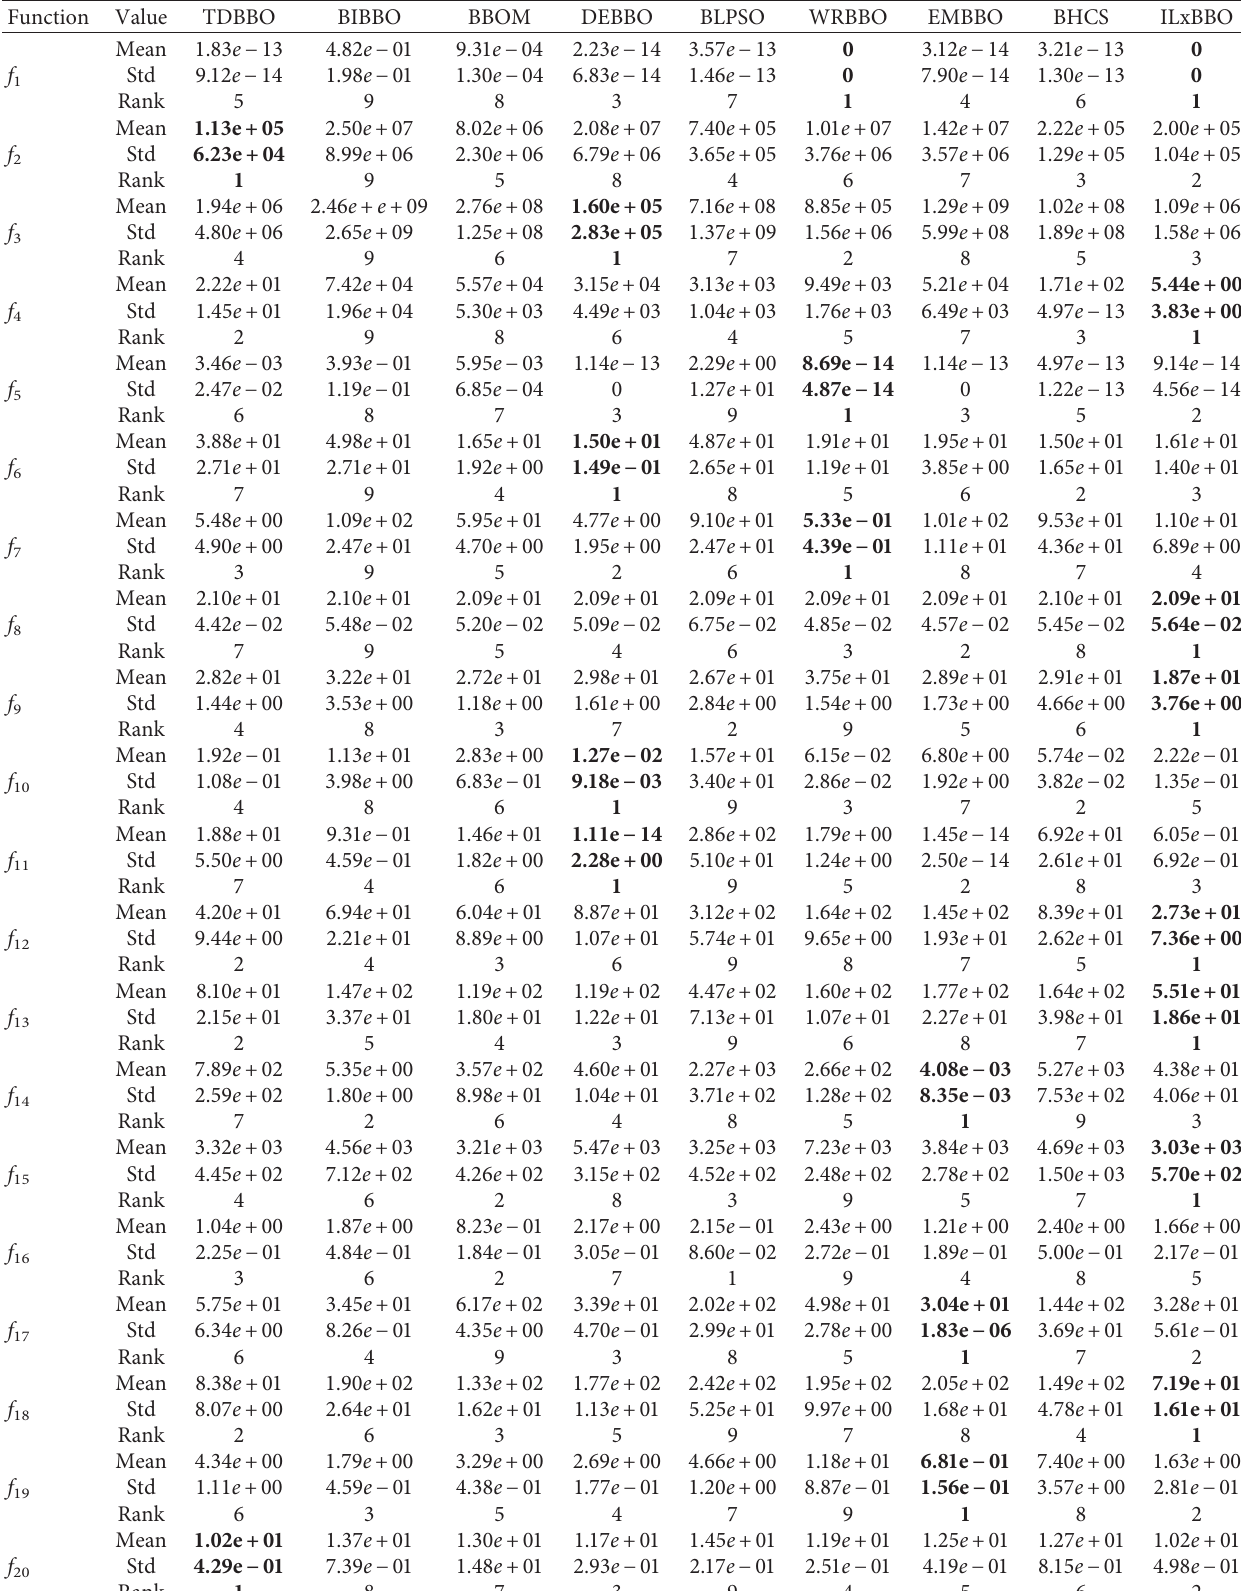
Table 2: Comparison results among ILxBBO and BBO’s variants on the 30-dimensional functions.